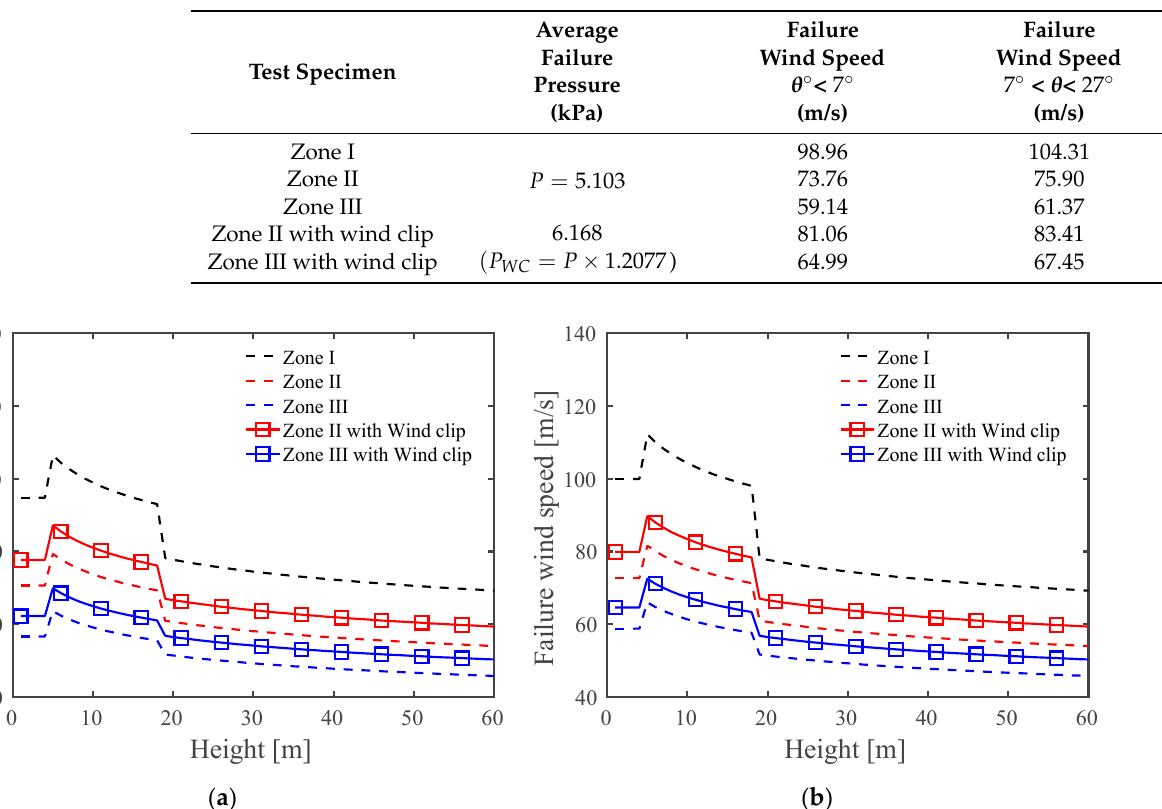
Figure 11. Failure wind speed vs. SSMR height increase of three roof zones with and without wind clip enhancement. ( a ) Roof angles less than 7 ° ; ( b ) roof angles between 7 ° and 27 ° . Table 5. Failure wind speed with and without wind clips at 10 m building height.